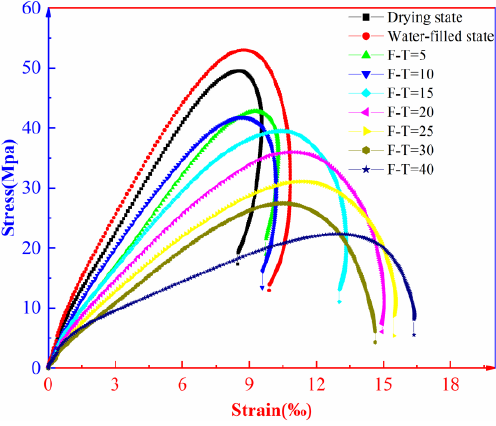
Figure 6. Dynamic stress – strain curves of muddy siltstones after F-T